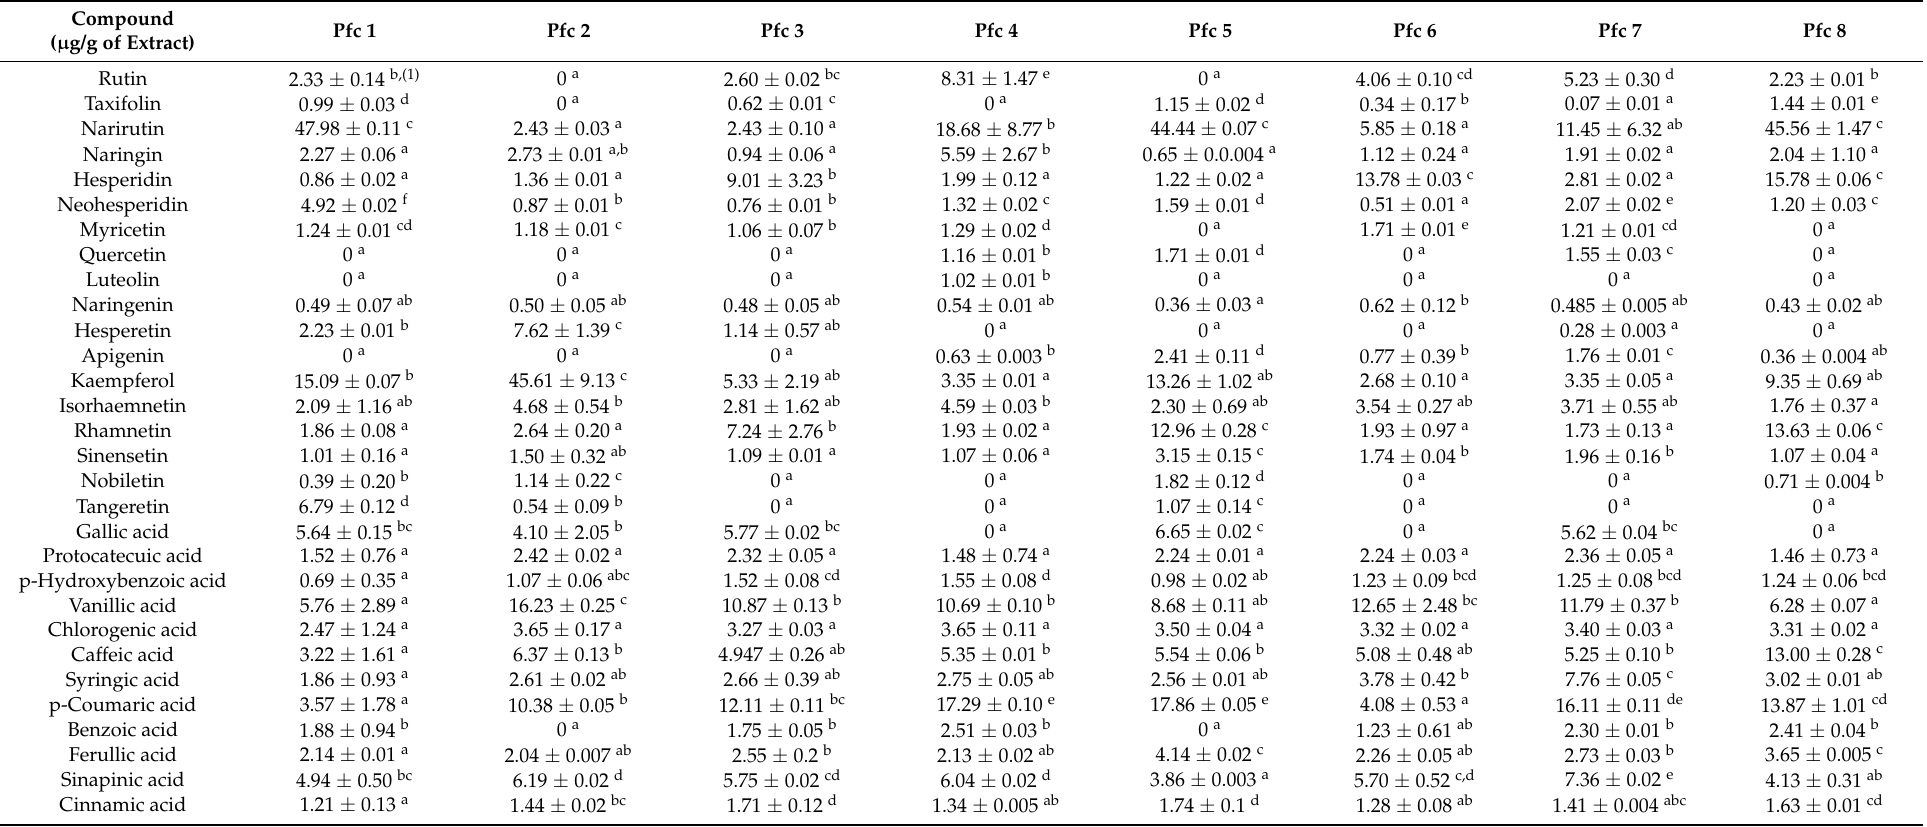
Table 1. Polyphenolic compounds in different Perilla frutescens var. crispa